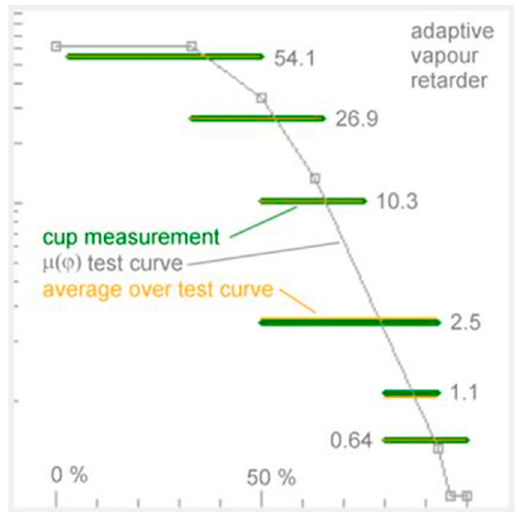
Figure 6. Example of plotted hygrothermal curve boundary of an adaptive vapour retarder from WUFI.